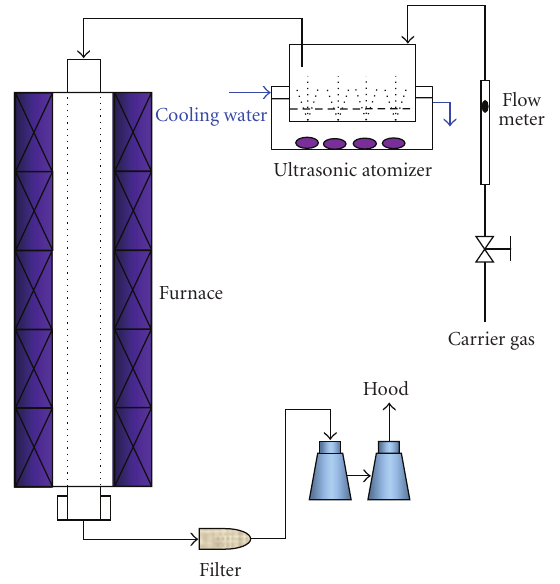
Figure 1: Schematic diagram of spray pyrolysis experimental apparatus.